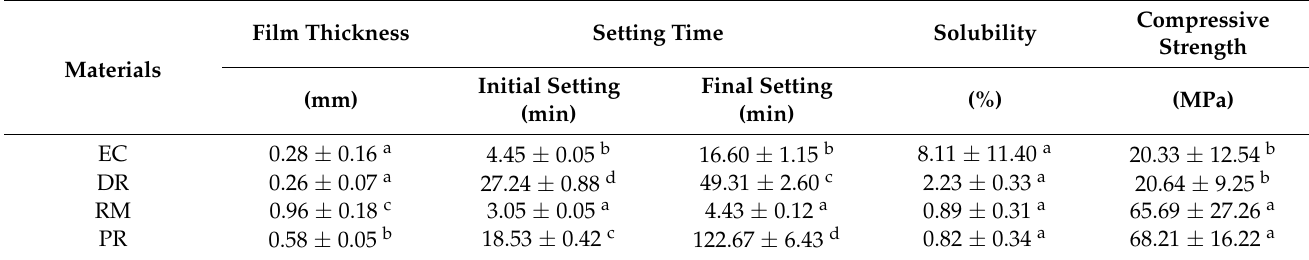
Compressive Strength